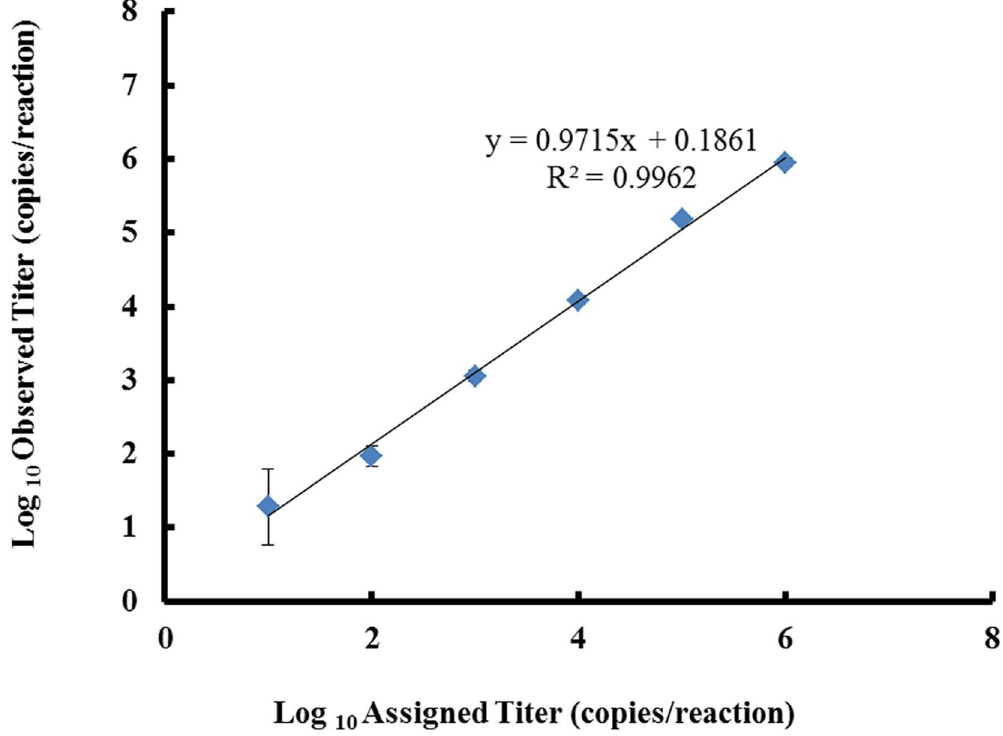
Fig 2. Graphic depiction of the linear range of detection (10 2 to 10 6 copies/reaction) of the dengue virus genome by the LightMix Dengue virus EC qRT-PCR